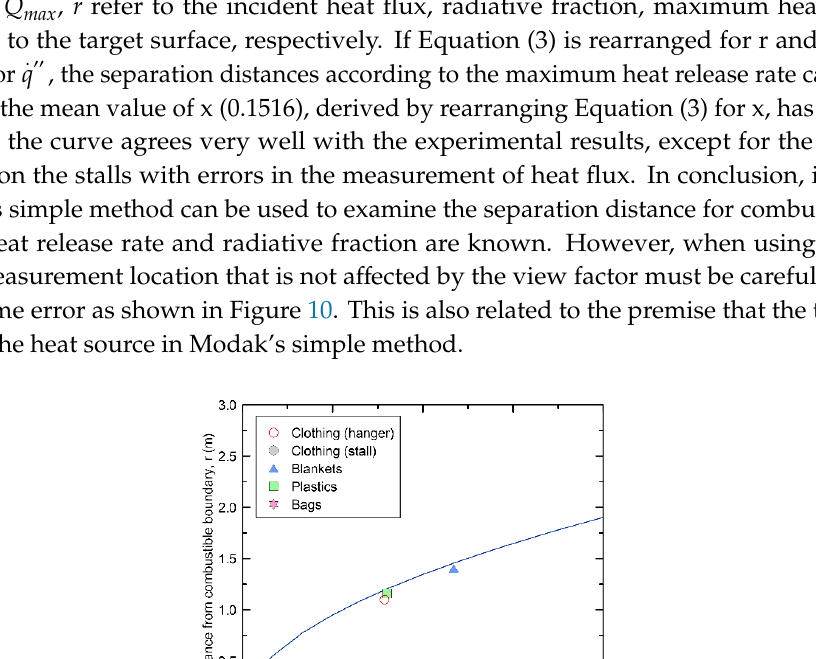
Figure 11. Correlation of separation distance according to maximum heat release rate.